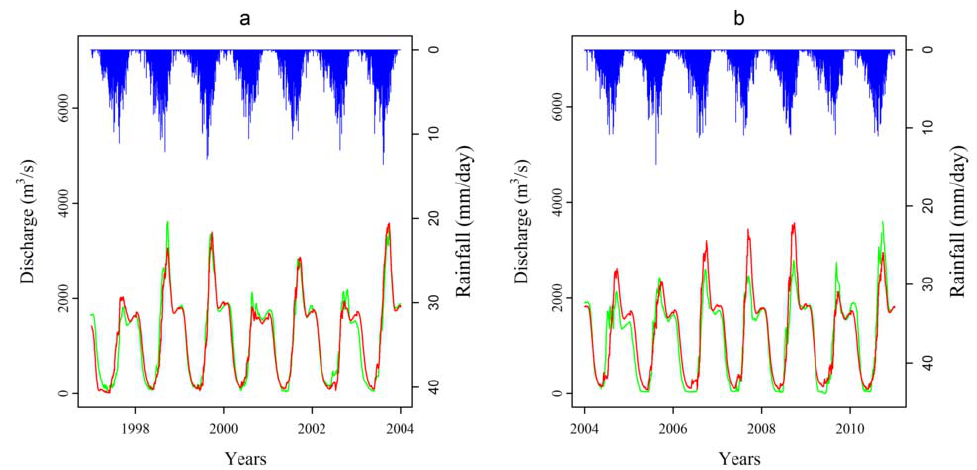
Figure 2. Calibration ( a ) and validation ( b ) of the hydrological model with observed data in the Niger Basin; inverted blue bars represent GPCP rainfall while green and red lines are observed and simulated runoff, respectively.